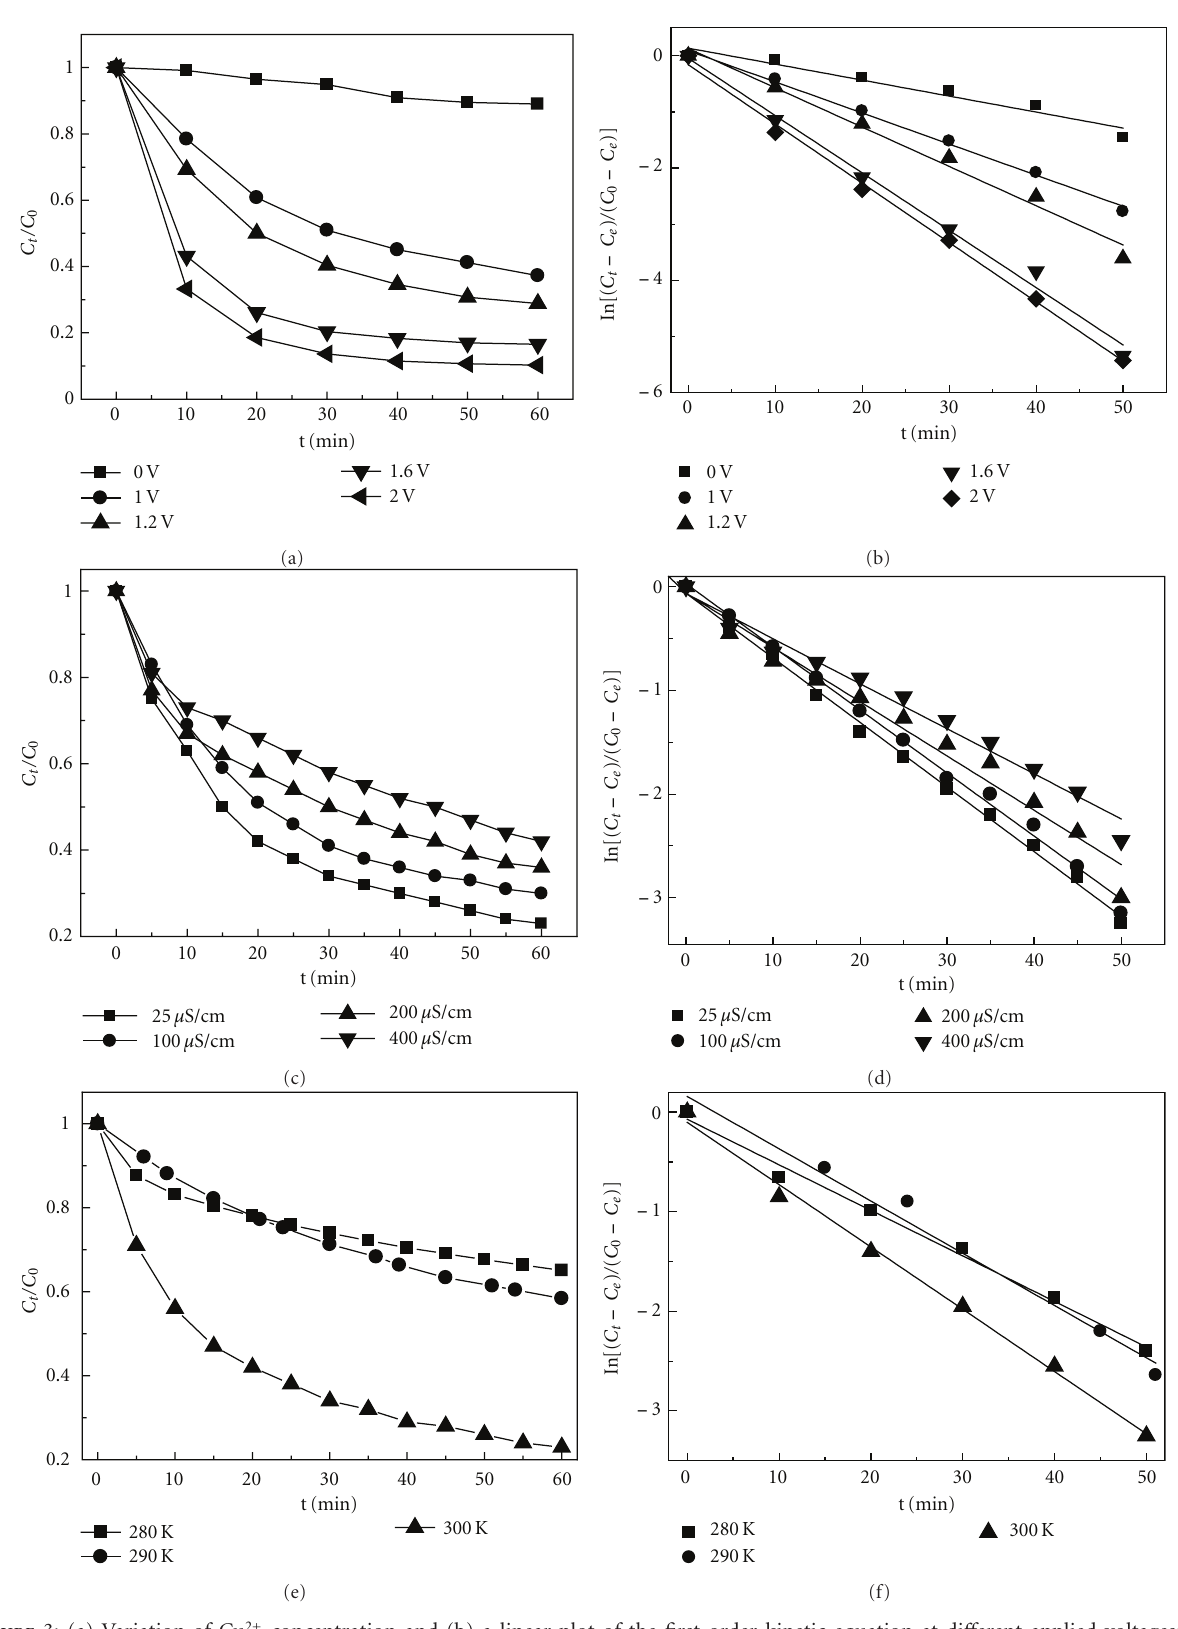
Figure 3: (a) Variation of Cu 2+ concentration and (b) a linear plot of the first-order kinetic equation at di ff erent applied voltages; (c) variation of Cu 2+ concentration and (d) a linear plot of the first-order kinetic equation at di ff erent initial solution conductivities; (e) variation of Cu 2+ concentration and (f) a linear plot of the first-order kinetic equation during batch mode experiments at di ff erent solution